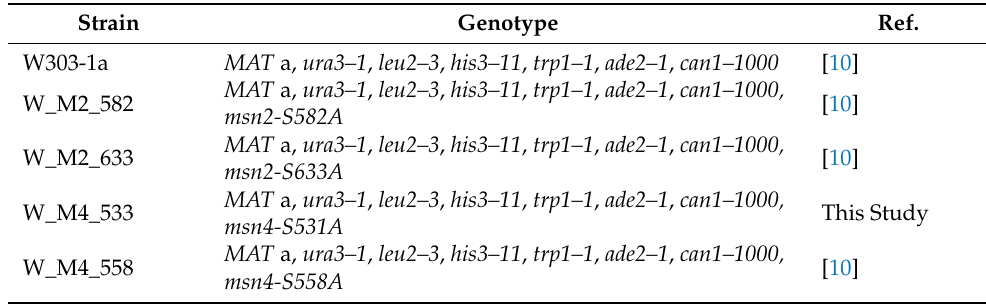
Table 1. Strains used in the current